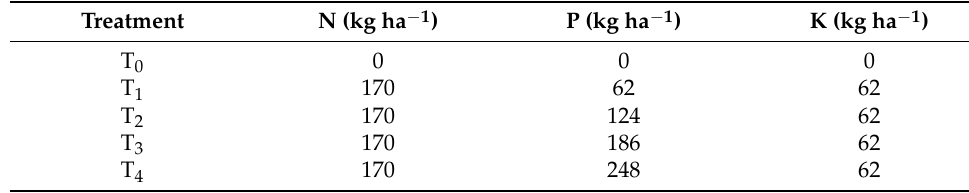
Table 3. Treatments applied to rice in pot